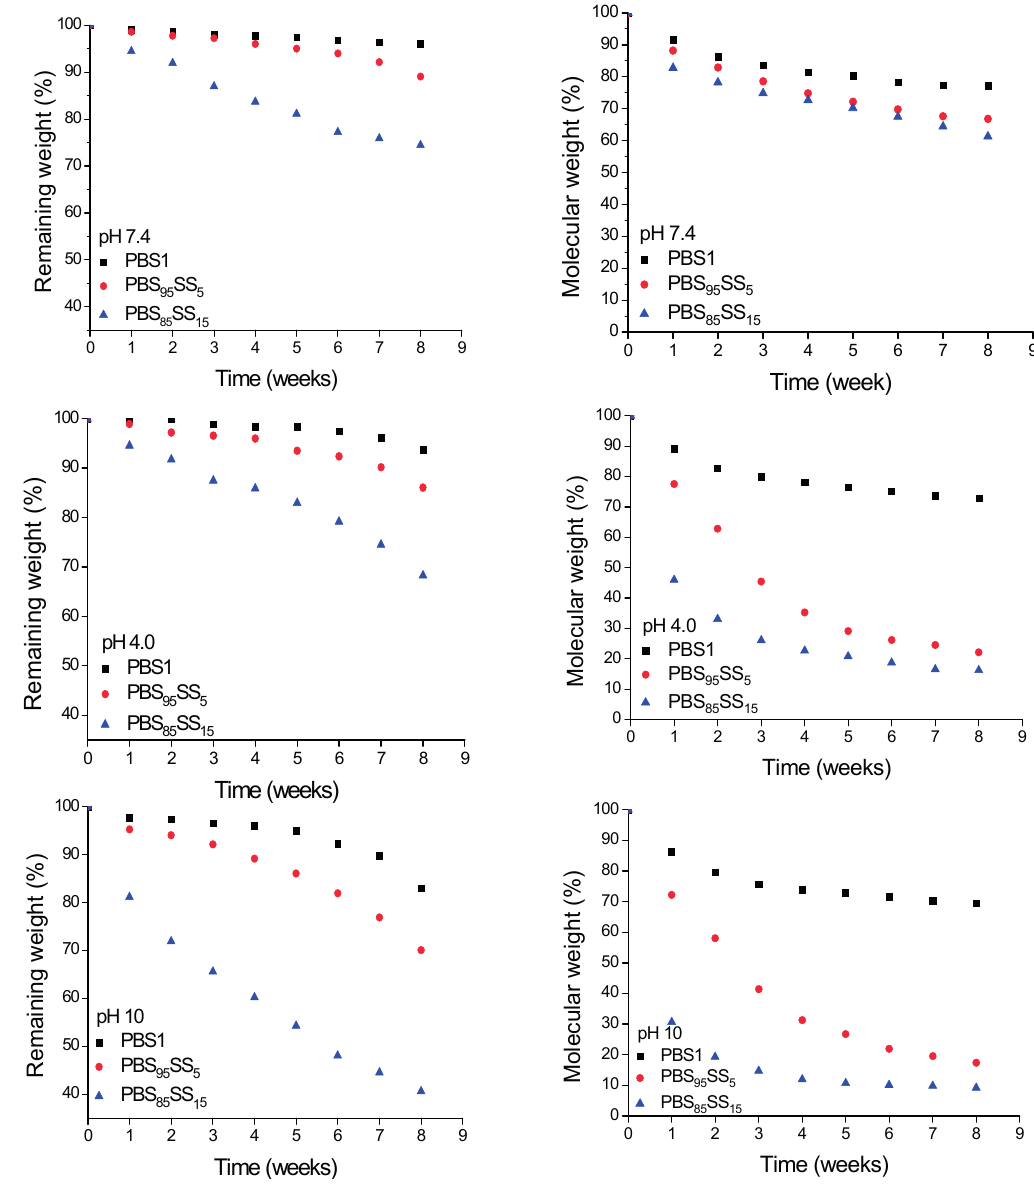
Figure 4. Evolution of sample remaining weight ( left ) and weight average molecular weight ( right ) for PBS1, PBS 95 SS 5 and PBS 85 SS 15 at pH 7.4, 4.0 and 10 ( top to bottom ) at 37 °C, as a function of incubation